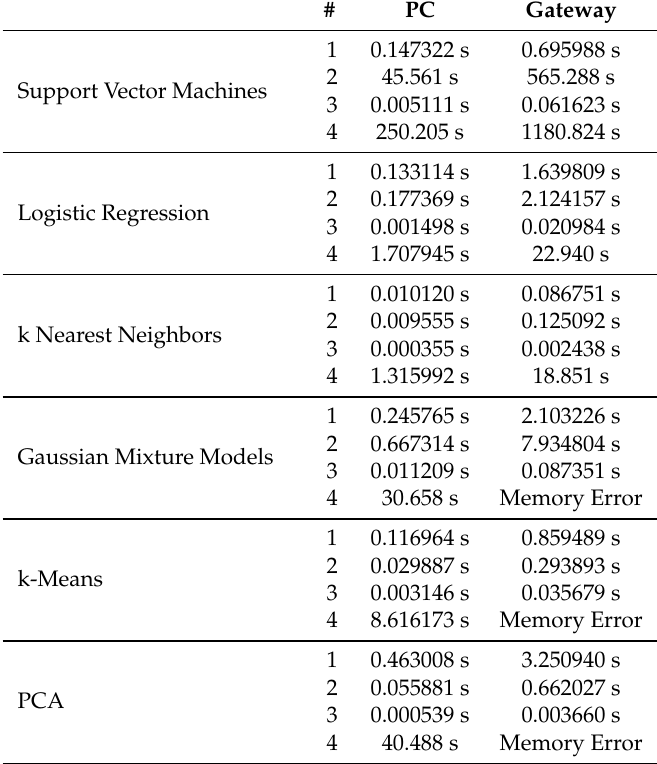
Table 5. Execution times of common machine learning algorithms. Each row corresponds to the equivalent dataset in Table